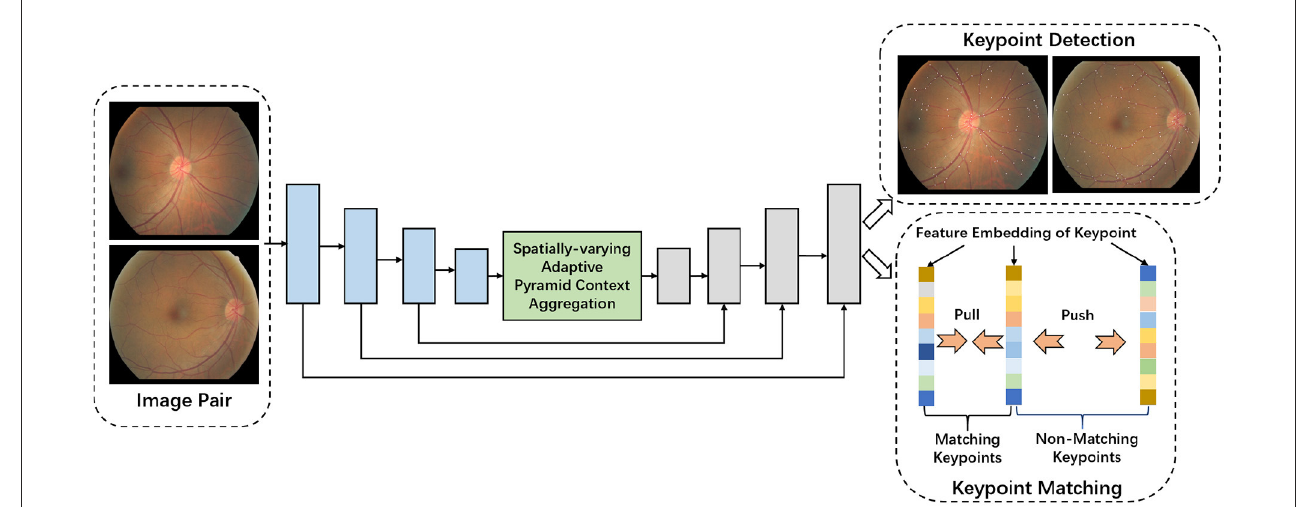
FIGURE1 Overview of the proposed network for simultaneous keypoints detection and keypoints